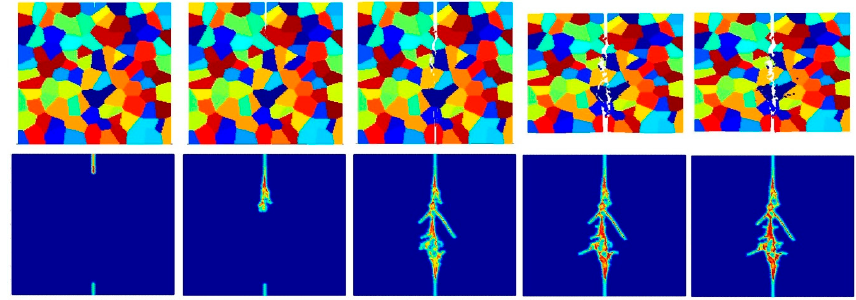
Figure 27. Fracture pattern of polycrystal when β = 1.0 with 100 grains in total. From left to right: time = 1.5 μ s, 2.0 μ s, 2.5 μ s, 3.0 μ s, and 3.5 μ s, respectively.